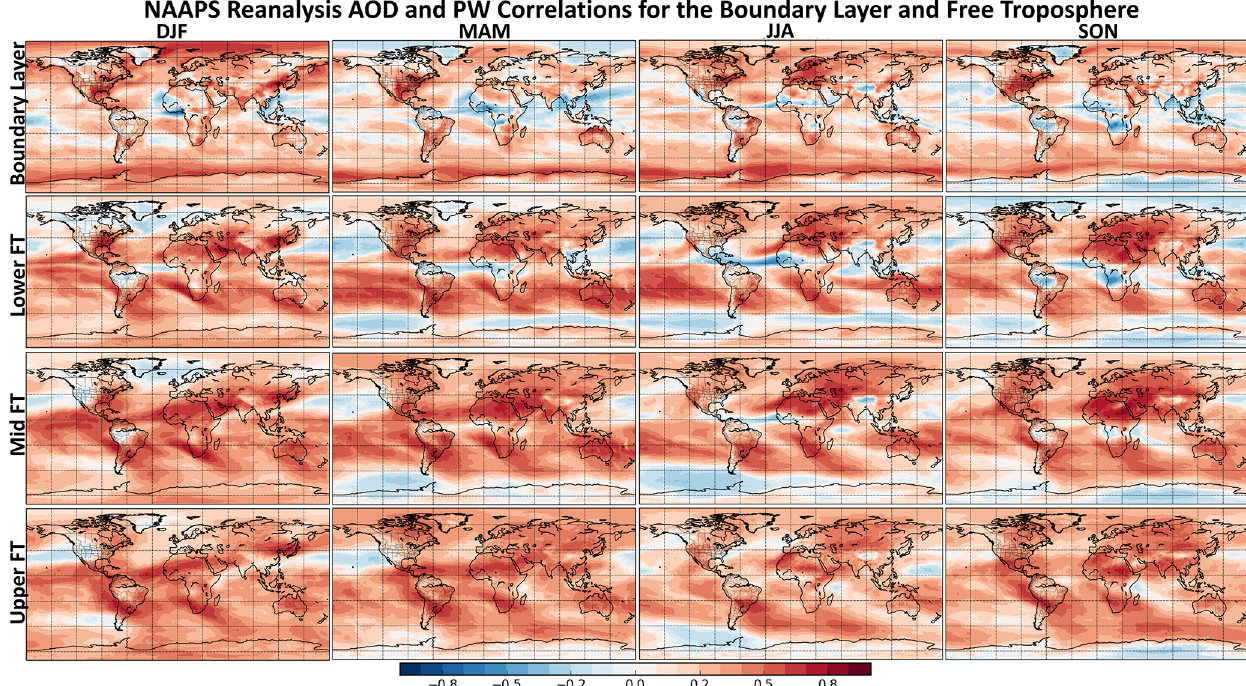
Figure 11. NAAPS-RA seasonal correlations (DJF, MAM, JJA, SON) between vertically integrated total aerosol extinction and specific humidity in the boundary layer, lower free troposphere, middle free troposphere, and upper free troposphere. Red values indicate a positive correlation, and blue values indicate a negative